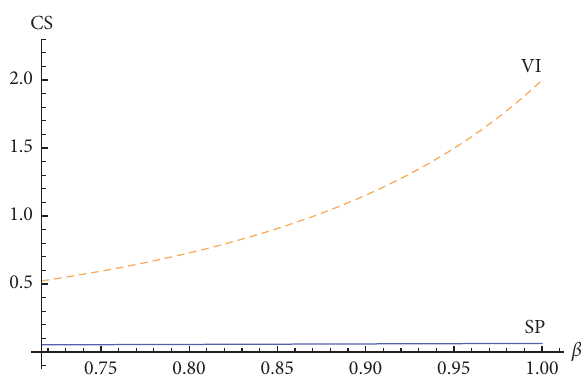
Figure 10: Consumer surplus comparison(p2 <